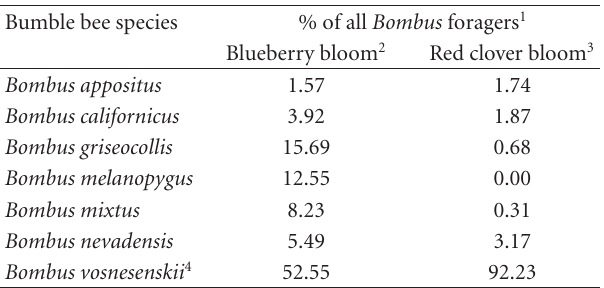
Table 1: Bumble bee species observed foraging on bloom in commercial blueberry and red clover seed production fields in western